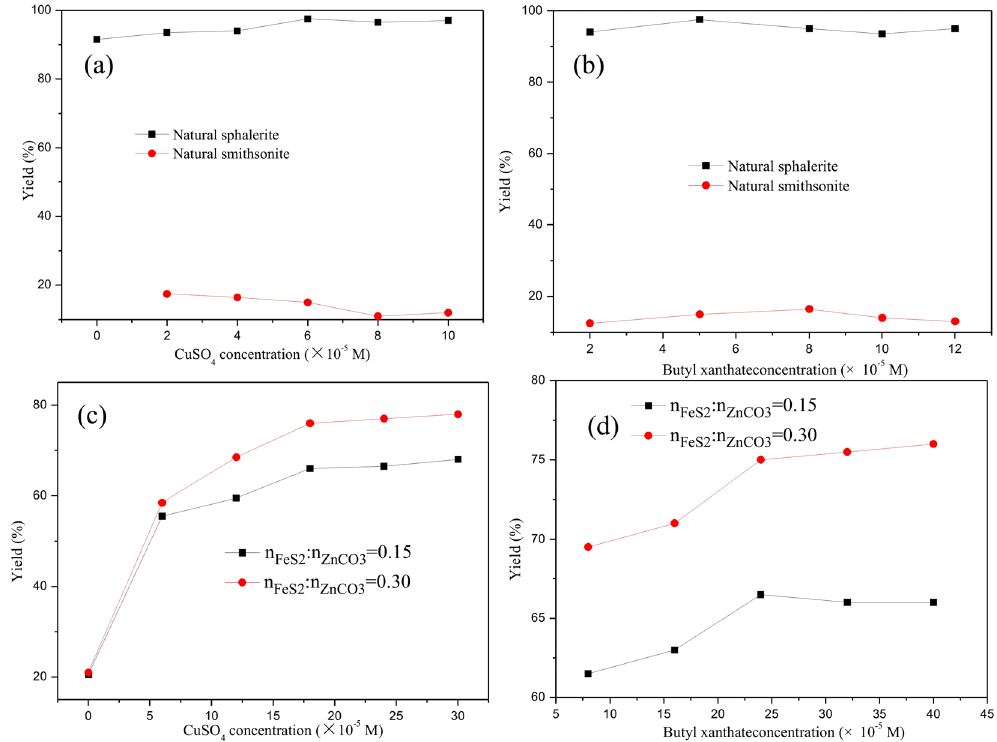
Figure 8. Flotation performances of natural smithsonite before and after treatment and natural sphalerite at a natural pH and a terpineol dosage of 5 × 10 − 5 M ( a ) butyl xanthate concentrations: 5 × 10 − 5 M; ( b ) copper sulphate concentrations: 6 × 10 − 5 M; ( c ) butyl xanthate concentrations: 40 × 10 − 5 M; ( d ) copper sulphate concentrations: 18 × 10 − 5 M).